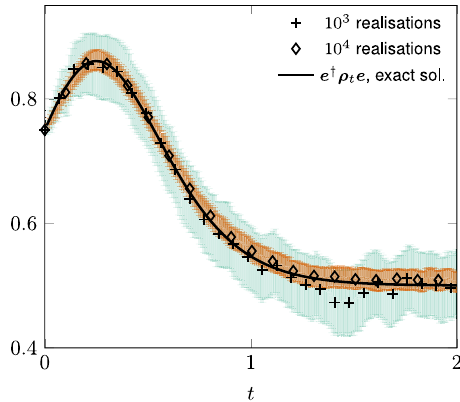
Fig. 2 Illustration of the in fl uence martingale for a qubit in a photonic Fig. 3 Illustration of the in fl uence martingale for the random unitary band gap. Monte Carlo averages versus master equation predictions for model. Monte Carlo averages versus master equation predictions for the ffiffiffi p ρ = (16). The scatter plots show f y 2 , with initial states energy level populations of the random unitary model (18). The Lindblad ffiffiffi t f 1 , with f 1 ¼ ð e þ g Þ p ffiffiffi ffiffiffi 1 p p ψ = f ψ ¼ f 2 ¼ ð e (cid:2) g Þ = 2 (x's) and their sum t Þ , Γ t Þ and weights are Γ 1 ; t ¼ (cid:2) 0 : 5 þ 2tanh ð 2 3 0 1 (diamonds) and 0 ffiffiffi p 2 ; t ¼ (cid:2) 1 þ 2tanh ð (crosses), where e and g are the excited and ground state of σ + σ − , Γ : 8 þ 2tanh ð t Þ . The initial condition of the qubit is ψ 5 ¼ ffiffi 3 ; t ¼ (cid:2) 0 0 p respectively. The data is obtained from 10 4 realizations. The continuous 3 e þ 1 g where g , e are the ground and excited state of σ 3 , respectively. 2 2 lines show the solutions obtained from directly integrating the master The black full line gives the prediction by solving the master equation (18). equation. The shaded area is determined by two times the square root of The crosses show the stochastic average after 10 3 realizations and the the ensemble variance of the indicator of interest. The starting time mesh (light) green shaded area displays fl uctuation-related errors estimated as in for the adaptive code is d t = 0.03. Fig. 2. Similarly, the diamonds show the ensemble average after 10 4 realizations and the (dark) brown shaded area the estimated trajectories by mapping (6) into a linear equation as described in Methods. The (black) full lines always denote predictions from the master equation. Monte Carlo averages are over ensembles of area shows twice the square root of the variance for 10 3 10 4 realizations. We theoretically estimate errors with twice the square root of the ensemble variance of the indicator of interest.